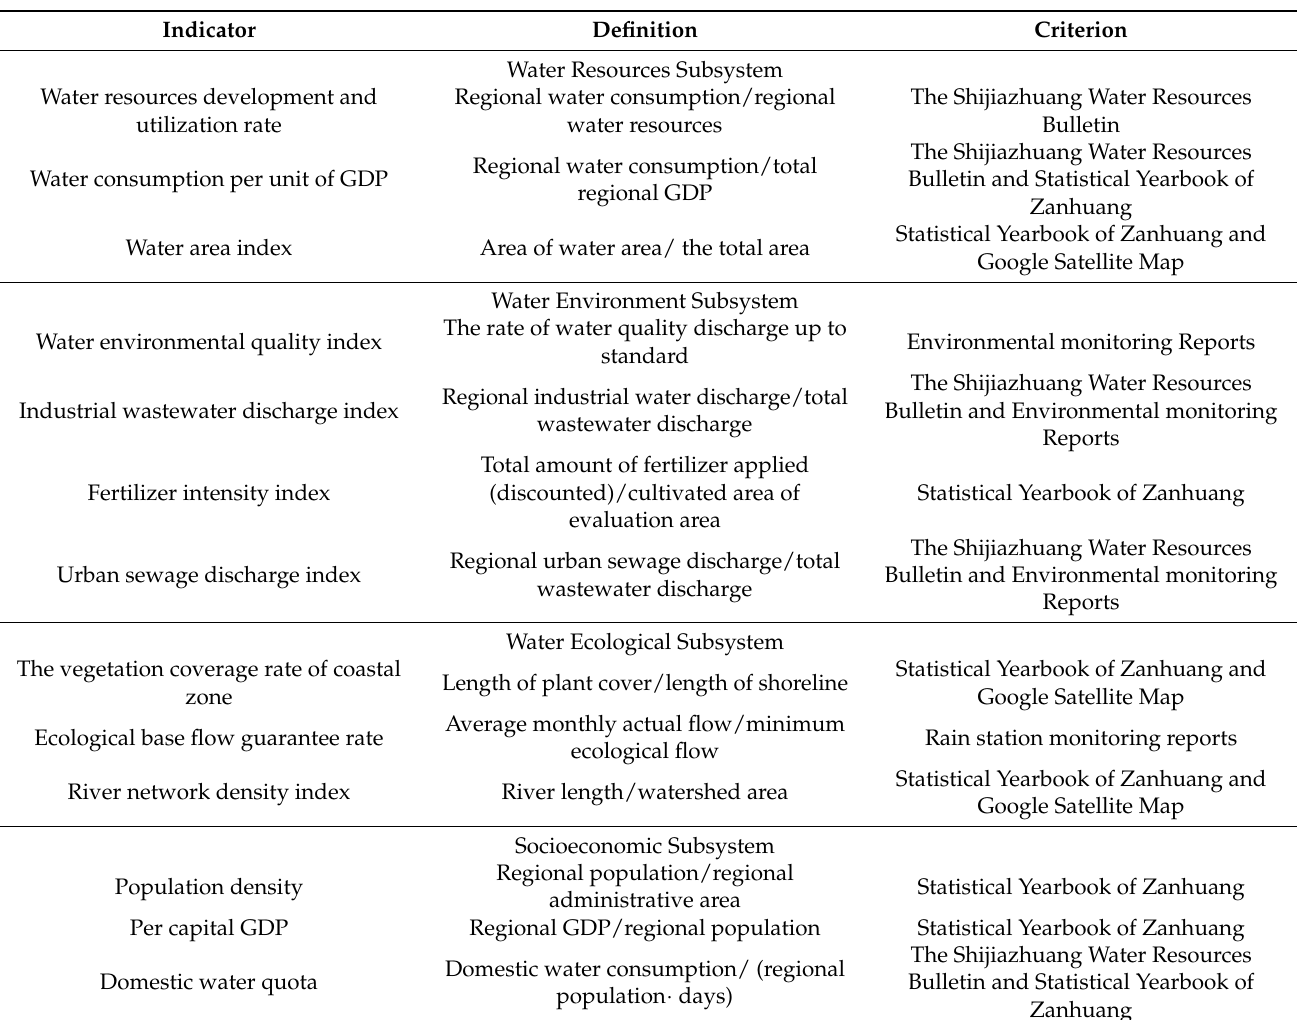
Table 2. Definition and criterion of each indicator in the index